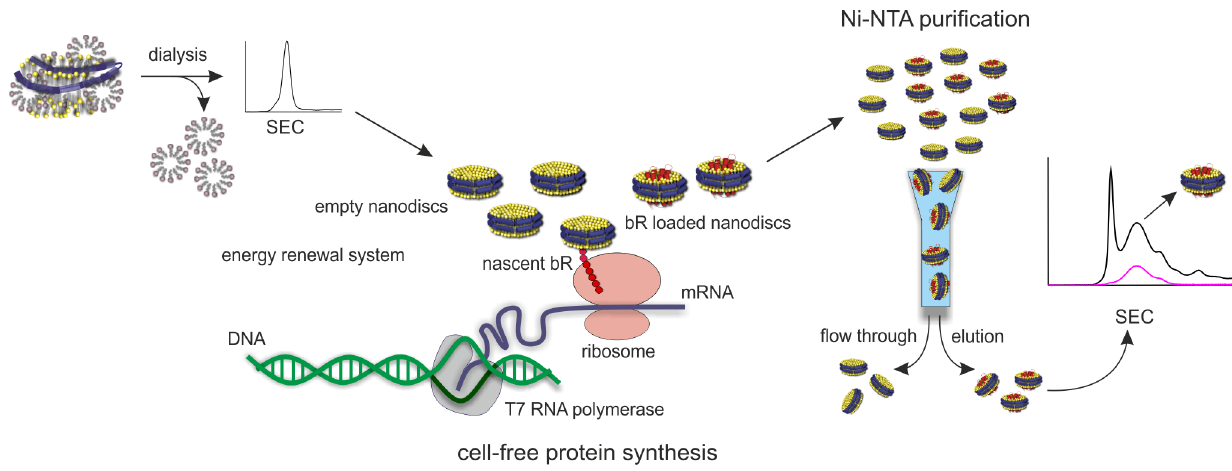
Figure 1. Scheme for the preparation of bR loaded nanodiscs. Empty nanodiscs were generated by incubating the lipid and MSP1 in the presence of a detergent. Detergent was removed by dialysis and nanodiscs were purified by size exclusion chromatography. The empty nanodiscs were added to the cell-free protein synthesis reaction. bR was incorporated co-translationally into nanodiscs and achieves correct folding. bR loaded nanodiscs were separated from empty nanodiscs by Ni-NTA and are further purified by size exclusion chromatography. bR was shown to be properly folded by its absorption maximum at 550 nm.